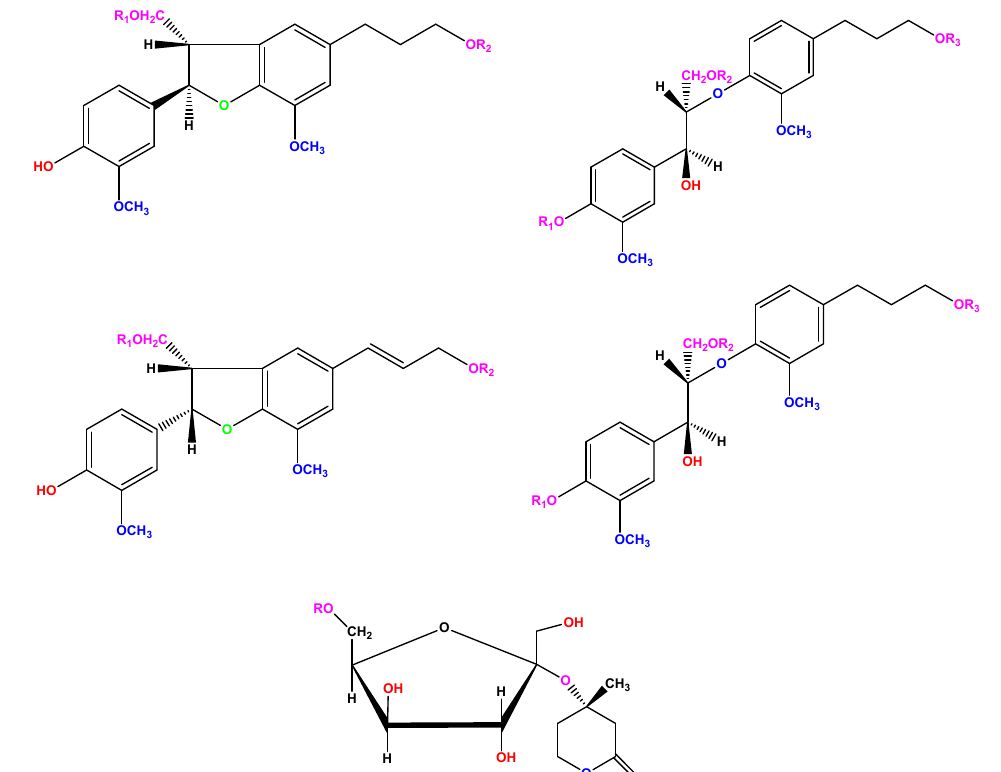
Figure 1. Structure of phytochemical constituents of T. aralioides .